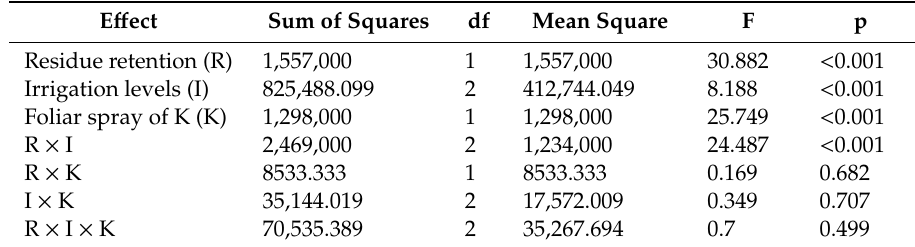
Table 2. Analysis of variance of residuals of regression between GY vs Water available to the crop as a ff ected by